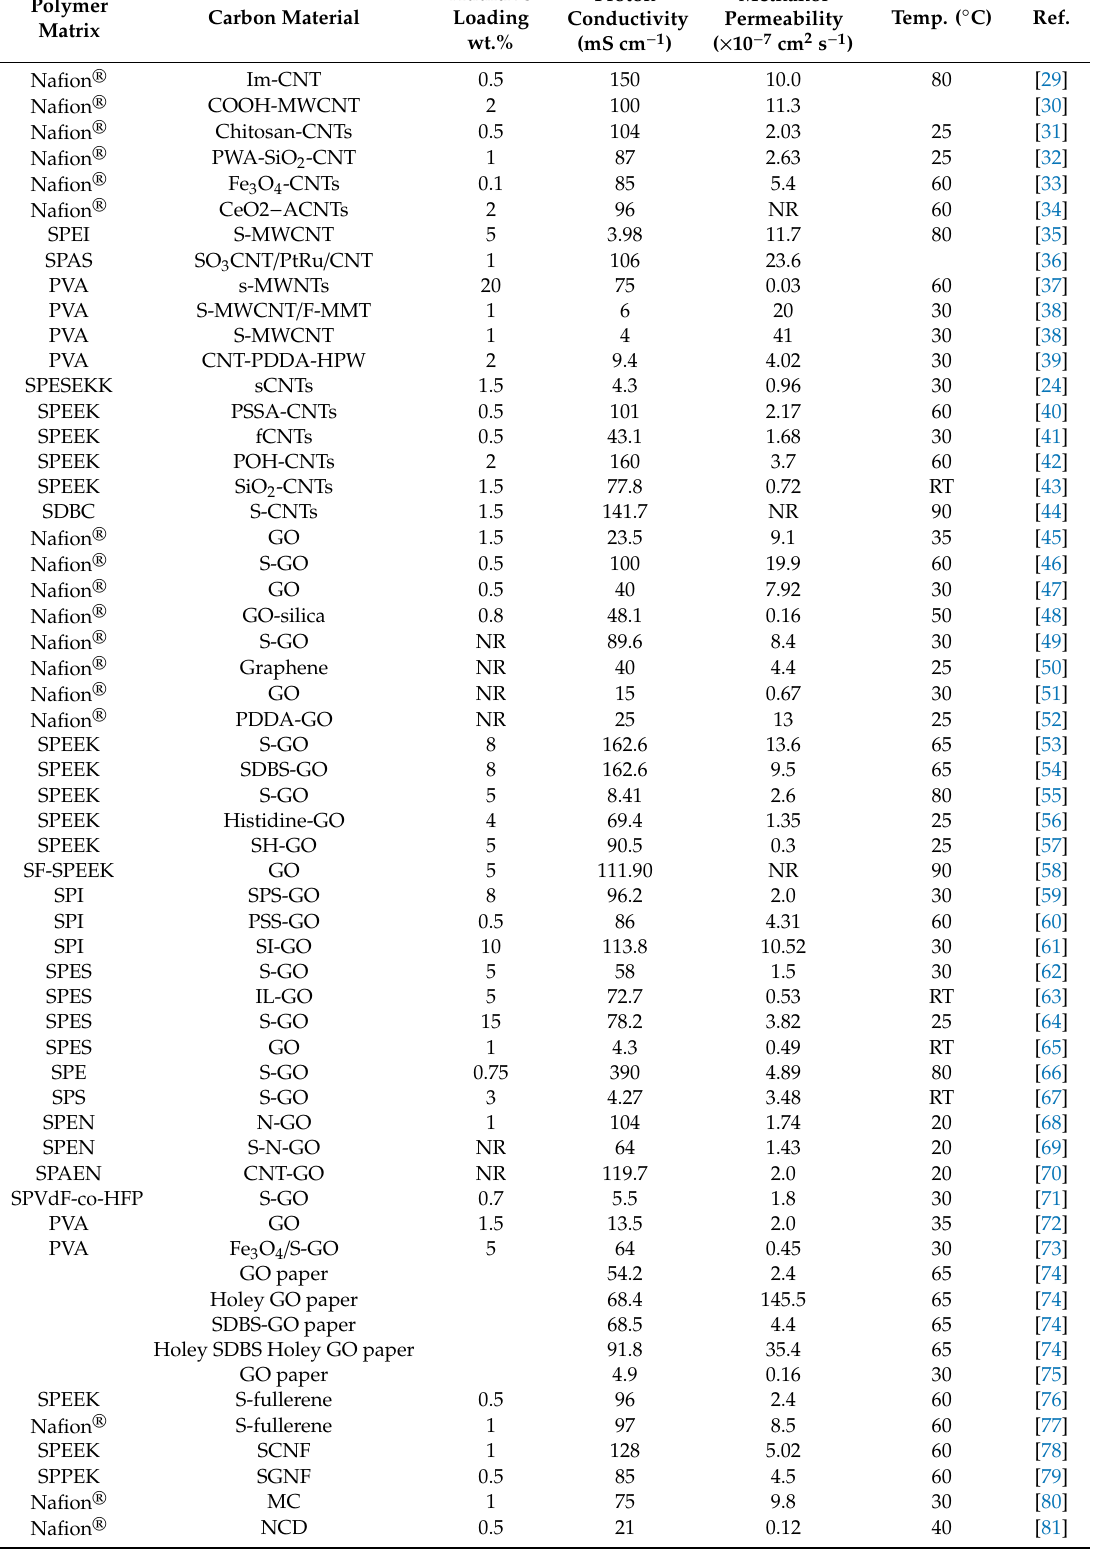
Table 1. Summary of properties of polymer electrolytes reported in the literature using carbon nanomaterials as